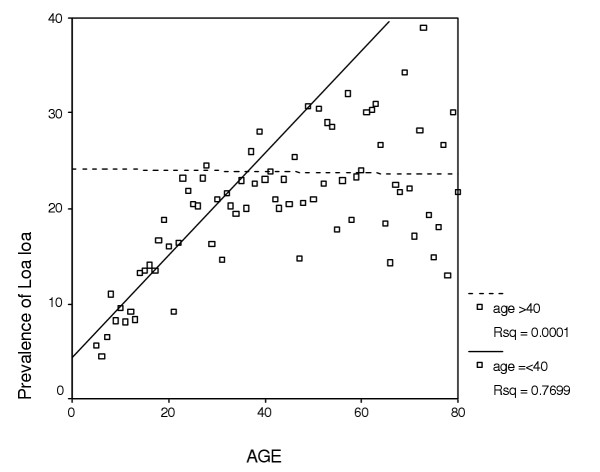
Relationship between prevalence of Loa loa microfilaraemia and age.